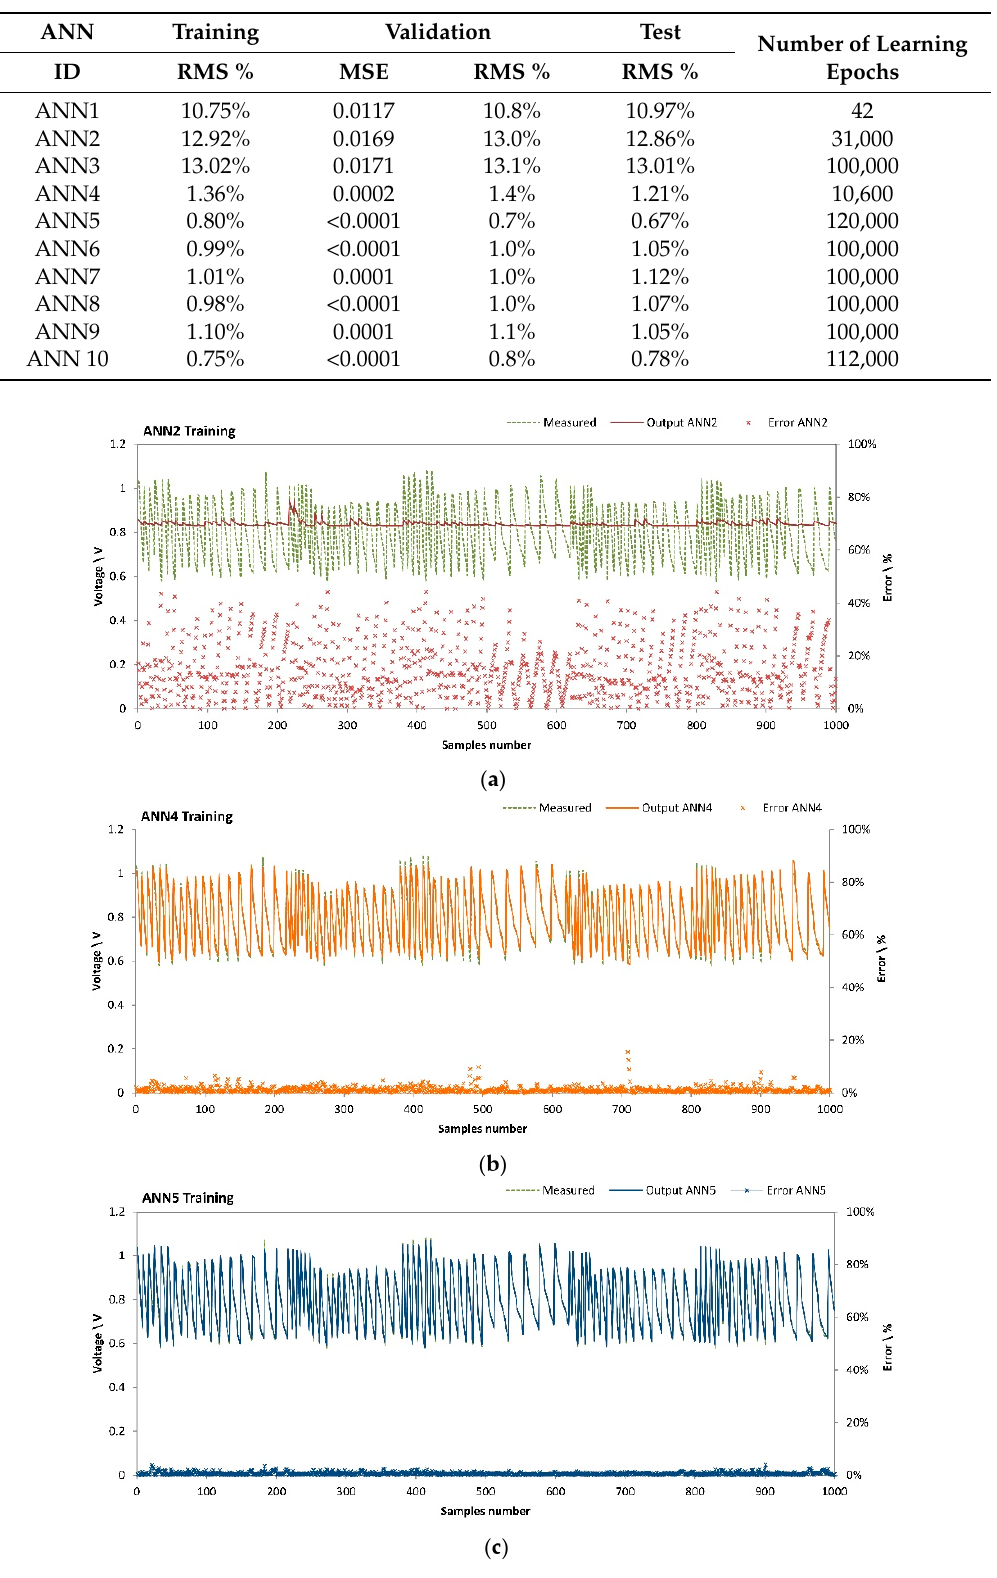
Table 4. Artificial neural networks performances.